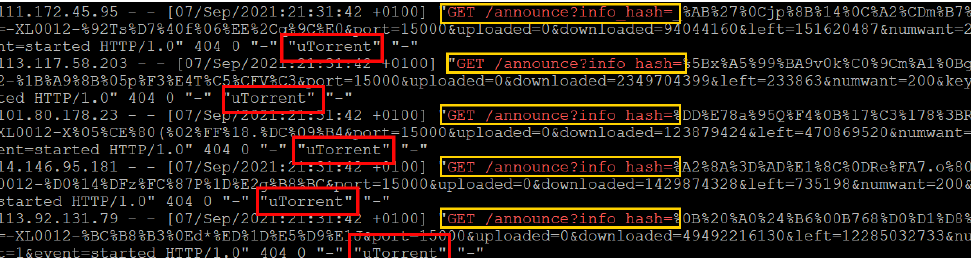
Figure 7. Web Log’s relative